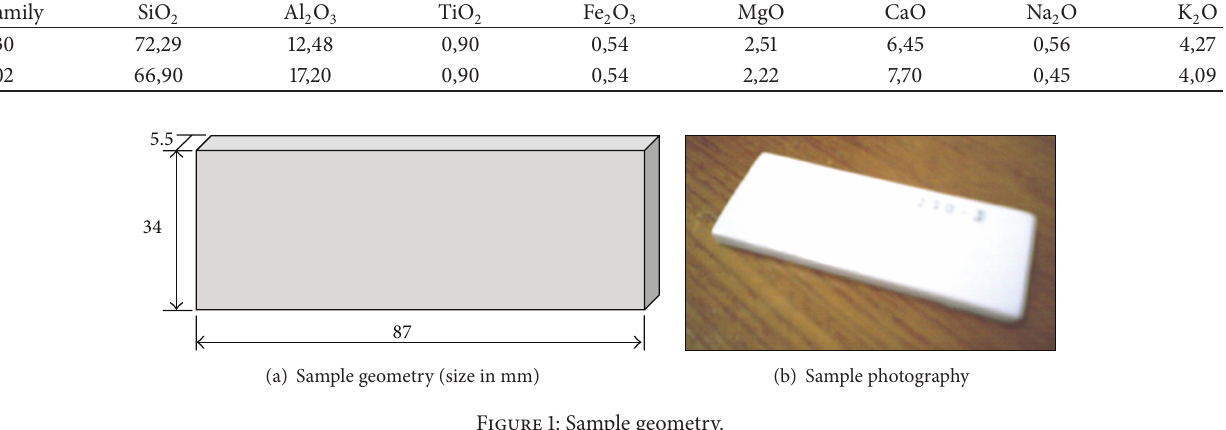
Figure 1: Sample geometry.